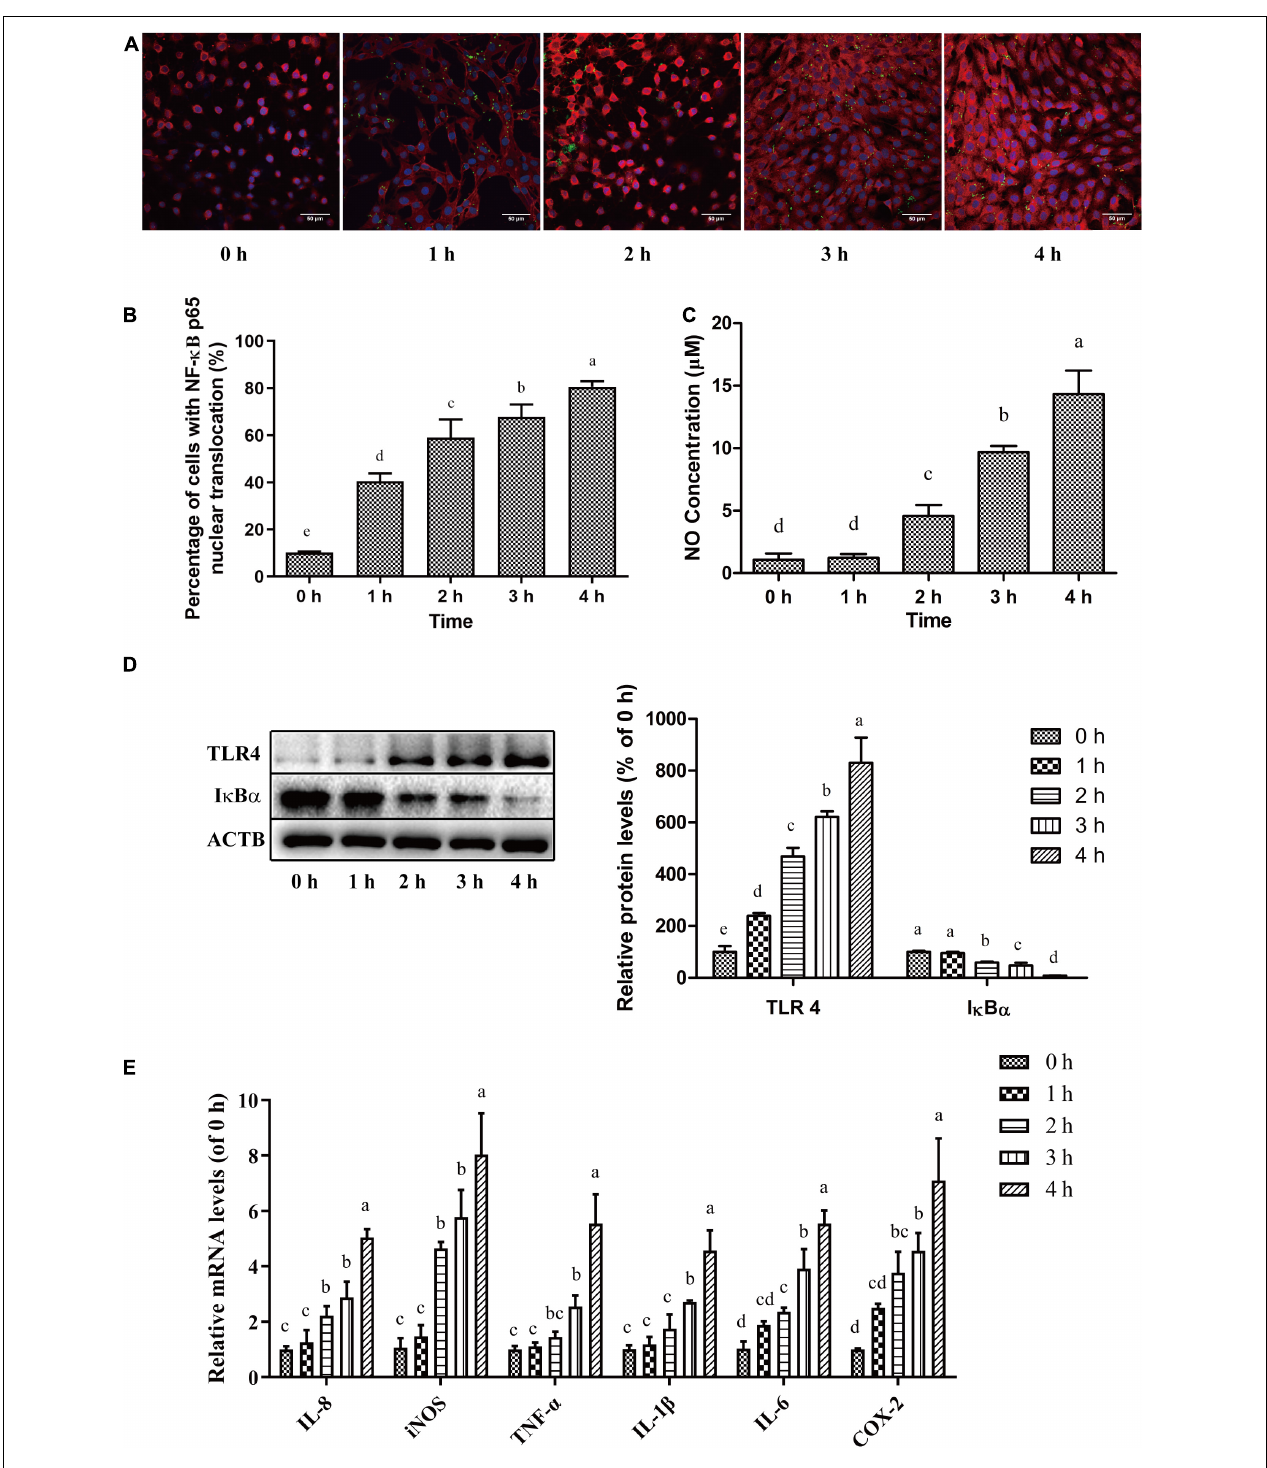
FIGURE 3 | C. sakazakii infection induced inflammatory responses in HBMEC. After C. sakazakii infection, the nuclear translocation of NF- κ B p65 in HBMEC was analyzed with immunofluorescent staining. (A) Representative fluorescence micrograph and (B) quantitative analysis were presented. (C) The concentrations of NO in culture medium supernatant was measured. (D) The blots (left) and quantitative analysis (right) for I κ B α and TLR4 protein in HBMEC after C. sakazakii infection. (E) Relative mRNA levels of IL-8, IL-6, TNF- α , IL-1 β , iNOS, and COX-2 in HBMEC after C. sakazakii infection for 0, 1, 2, 3, and 4 h. Error bars represent the standard deviation ( n = 3). Mean values with different lower-case letters are statistically different from one another ( P < 0.05).